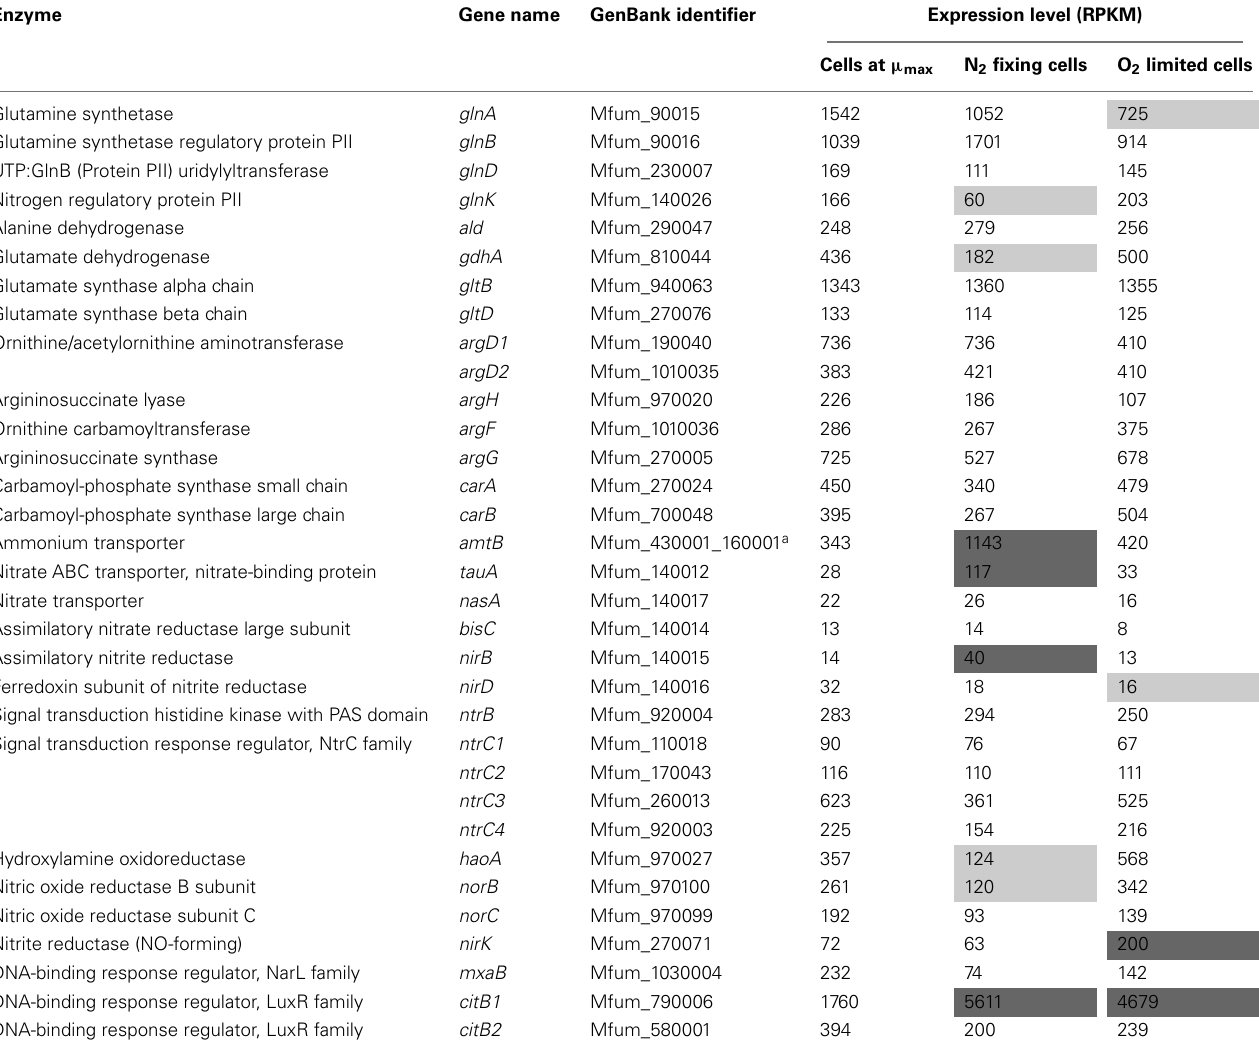
Table 3 |Transcription of genes involved in nitrogen metabolism in “ Ca. M. fumariolicum ” strain SolV.